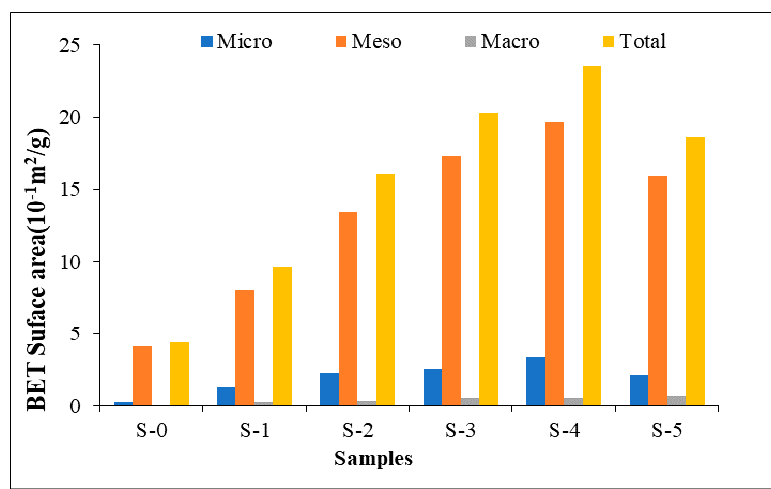
Figure 6. Surface areas of six shale samples.